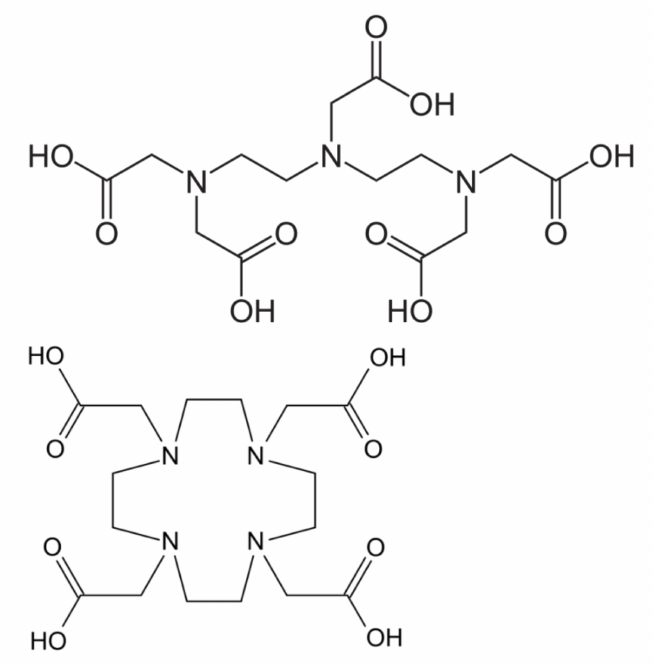
Figure 1. Chemical structure of a linear chelator, DTPA ( top ) and a macrocyclic chelator, DOTA ( bottom ), illustrating the ligands that bind to Gd. Macro-cyclic Gd(III) compounds are considered less likely to release free Gd(III) ions in the human body than linear chelates